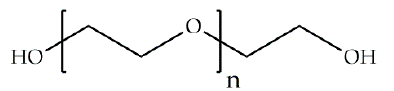
Figure 8. Molecular structure of poly(ethylene glycol) (PEG).